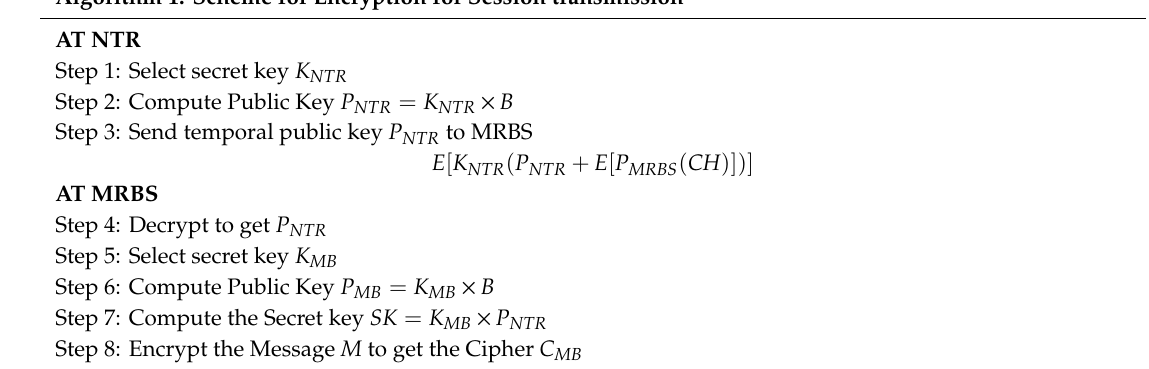
Algorithm 1: Scheme for Encryption for Session transmission AT